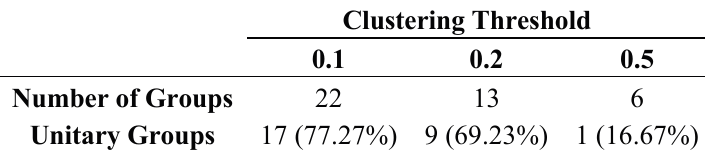
Figure 14. Evolution of clusters. Table 2. Clustering